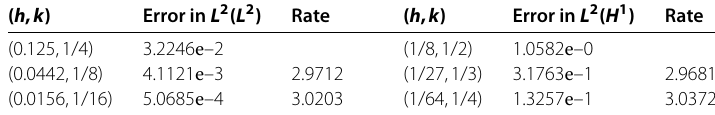
Table 7 The errors and convergence rates of u – u hk in the L 2 ( L 2 ) and L 2 ( H 1 ) norms